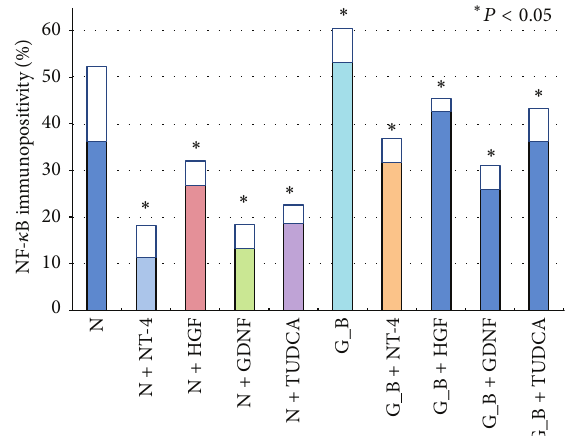
Figure 3: Graph showing the ratio of NF- 𝜅 B immunopositive cells to all cells in the GCL of retinal explants. N, serum-free media; G B, glucose-AGE-BSA; Glycol, glycolaldehyde-AGE-BSA; Glycer, glyceraldehyde-AGE-BSA; NT-4, neurotrohin-4; HGF, hepatocyte growth factor; GDNF, glial cell line-derived neurotrophic factor; TUDCA, tauroursodeoxycholic